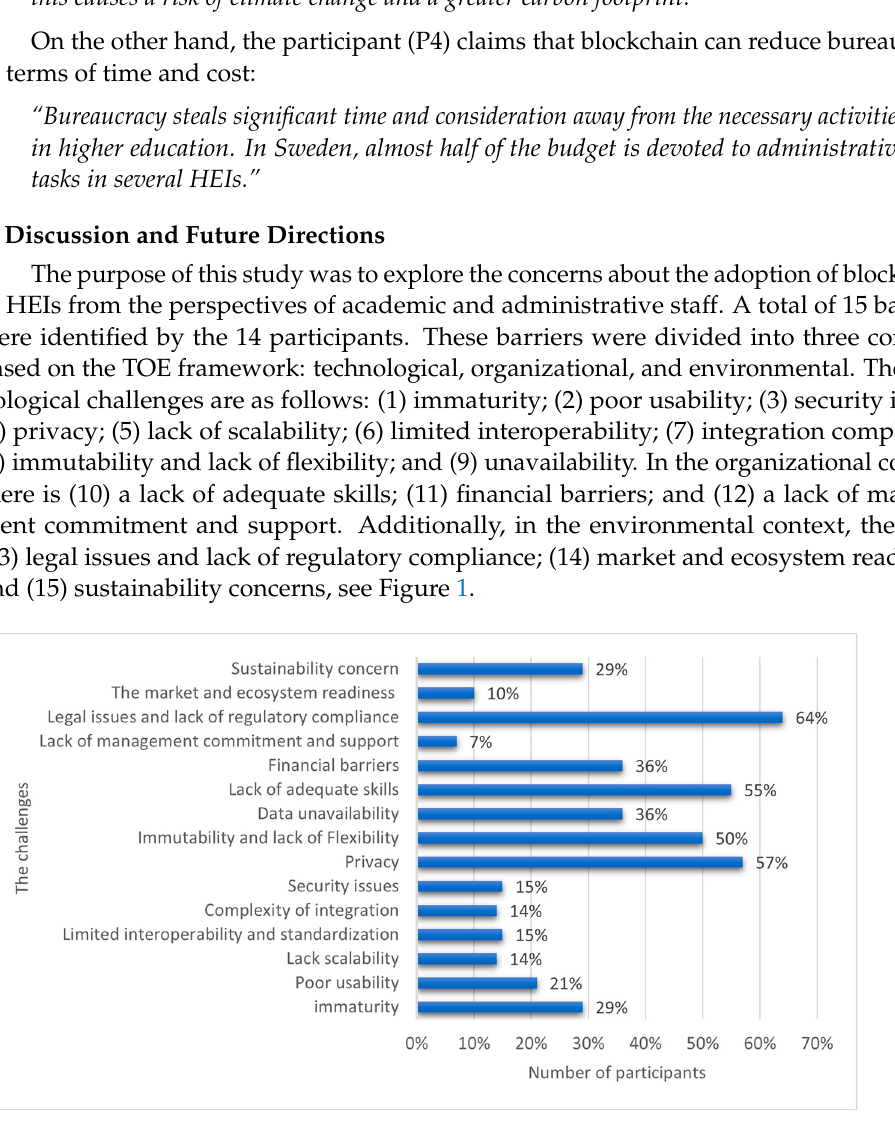
Figure 1. The challenges reported by the study’s participants.